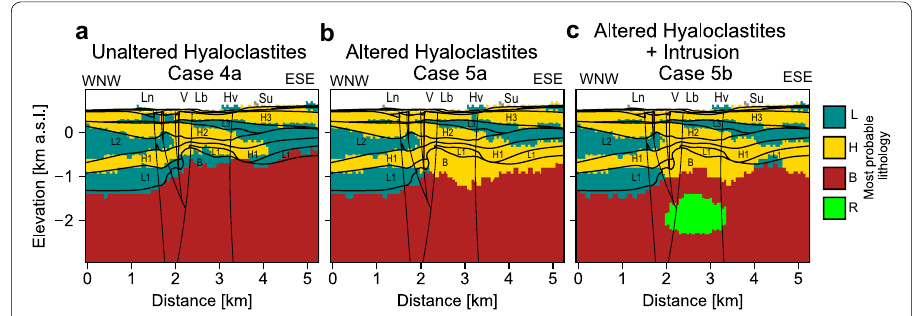
Fig. 14 Effect of considering hyaloclastite alteration and low-density intrusion on posterior results (Case 5a). Posterior results for most probable lithology assuming ( a ) prior properties of hyaloclastite assuming all data (Course 4a), ( b ) altered hyaloclastites (Course 5a), ( c ) altered hyaloclastites and a low-density intrusion beneath the main upflow (Case 5b), for an inversion also assuming a moderate commonality constraint and rougher shape ratio constraint. Results are shown along Section 3